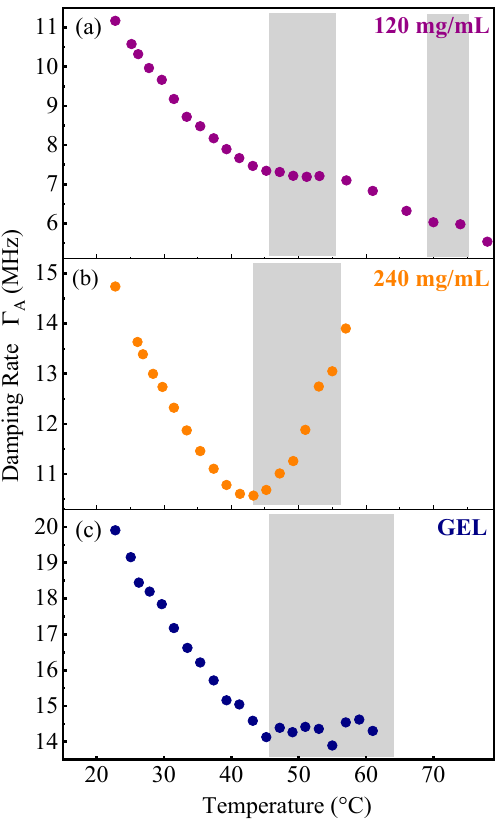
Figure 4. Temperature dependence of the acoustic damping rate measured on the samples for the 2.1 µm − 1 q-vector. ( a ) The diluted (120 mg/mL) lysozyme solution, ( b ) the concentrated (240 mg/mL) lysozyme solution, and ( c ) the gel system. The shaded band underlines the temperature zones characterized by different dynamic regimes.